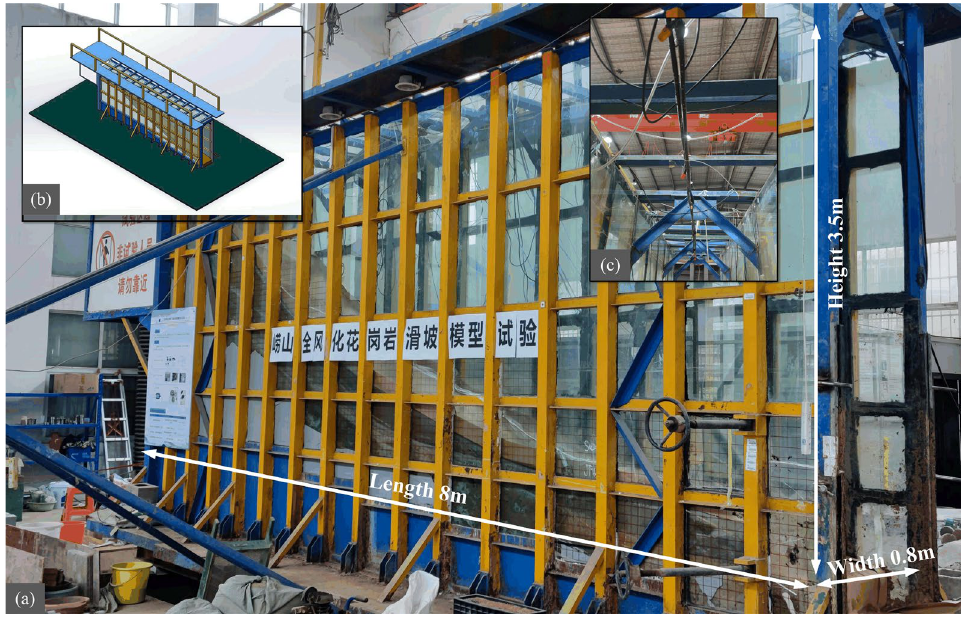
Fig. 6 a , b Model overview, c rainfall